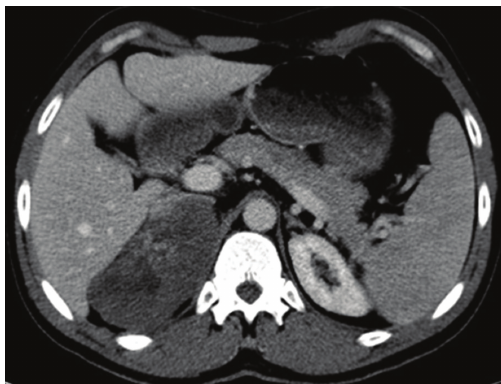
Figure 3: Axial CT scan at the nephrographic phase; there is still patchy central enhancement with nonenhancing peripheral part.